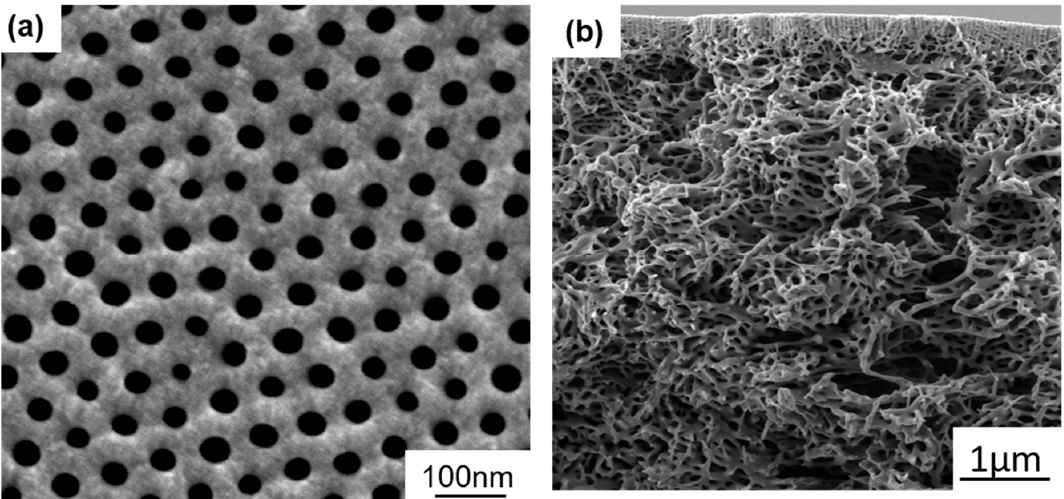
Figure 3. SEM images of ( a ) top view and ( b ) cross-section of PS 71 - b -P4VP 26 - b -PSMA 3145 membranes cast from 23 wt. % solution in a THF/DMF/acetone: 50/30/20 wt. %. Evaporation time was 10 s before immersion in water.